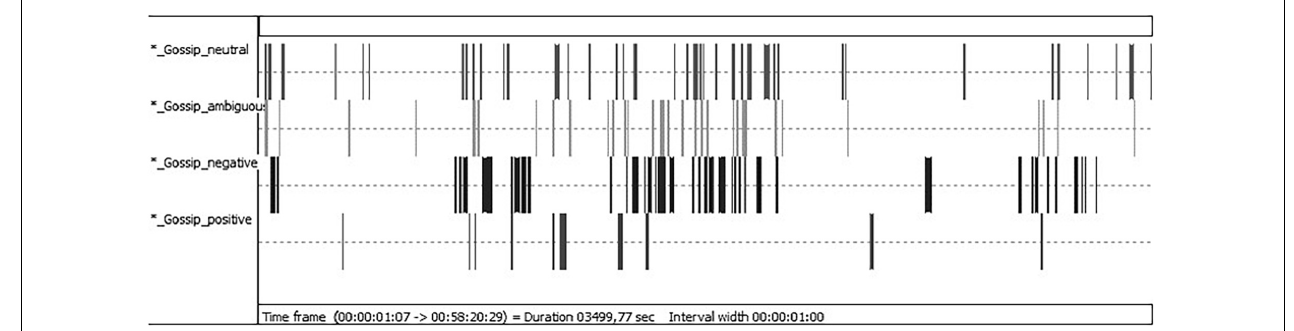
FIGURE 2 | Time line chart illustrating the flow of gossip events over the course of one sample meeting (generated with INTERACT software). The entire meeting is shown (approx. 58 min in total). The black and gray marks indicate that a gossip event was recorded. The first row shows instances of neutral gossip, the second row shows instances of ambiguous gossip, the third row shows instances of negative gossip, and the fourth row shows instances of positive gossip. The wider the marks, the longer the event was recorded